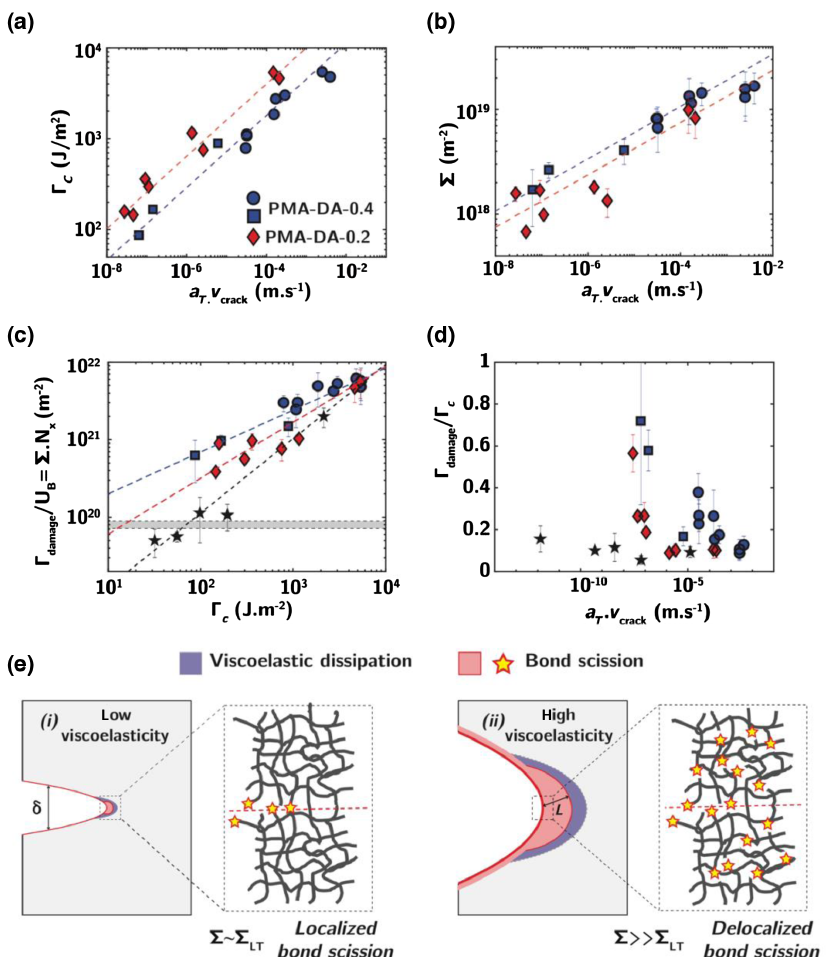
FIG. 5. Effect of molecular structure and contribution of bond scission to the fracture energy. (a) Fracture energy as a function of the rescaled velocity for two PMA samples with distinct cross-link densities (see Table I). Dashed lines show the power-law fit. (b) Absolute number of cleaved strands per unit area as a function of the rescaled velocities for the two samples. Dashed lines show power-law fits. ¼ Σ :N =U (c) Rescaled fracture energy due to bond scission Γ as a function of the total fracture energy Γ . Dashed lines are B x C damage power-law fits with power β ¼ 0 . 95 , 0.72, and 0.54, respectively for PEA-DA-0.5, PMA-DA-0.4, and PMA-DA-0.2. The gray area Þ ¼ Σ :N represents ð Γ 0 =U , the Lake-Thomas threshold for the three materials. Error bars in (b) and (c) show the standard deviation B x LT = Γ based on four local confocal measurements on each fractured sample. (d) Ratio Γ of the energy Γ dissipated by bond c damage damage v scission, over the total fracture energy Γ , as a function of the reduced crack speed a . The energy Γ is estimated assuming c T crack damage ¼ 60 kJ : mol − 1 . (e) Schematic coupling between viscoelasticity (blue domain) and strand breakage (red domain) at the crack tip. The U B enlarged region shows the occurrence of bond scission (yellow stars) in the elastomer network. Bond scission and viscoelastic dissipation are strongly coupled, with a joint increase in bond scission and viscoelastic dissipation between the low viscoelasticity (i) and large viscoelasticity regimes (ii). δ represents the crack tip opening displacement and L the characteristic spatial extension of bond scission at the crack